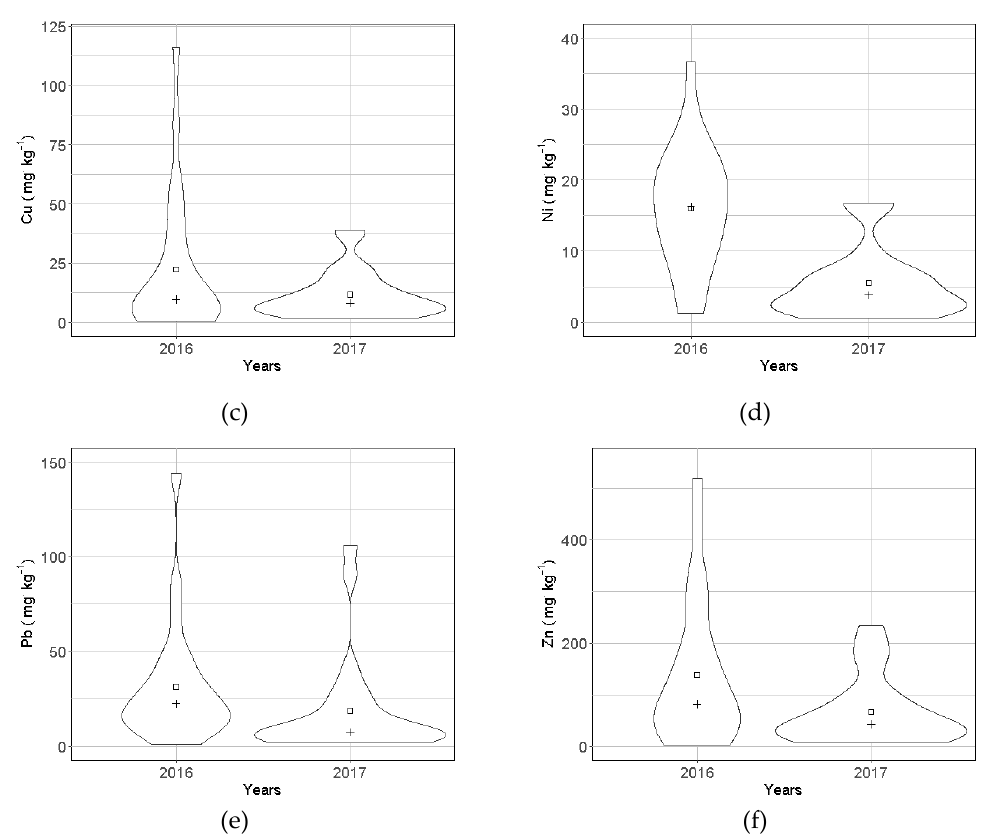
Figure 4. Variation of the concentrations of ( a ) Cd, ( b ) Cr, ( c ) Cu, ( d ) Ni, ( e ) Pb, and ( f ) Zn in the Warta River bottom sediments in 2016 and 2017.